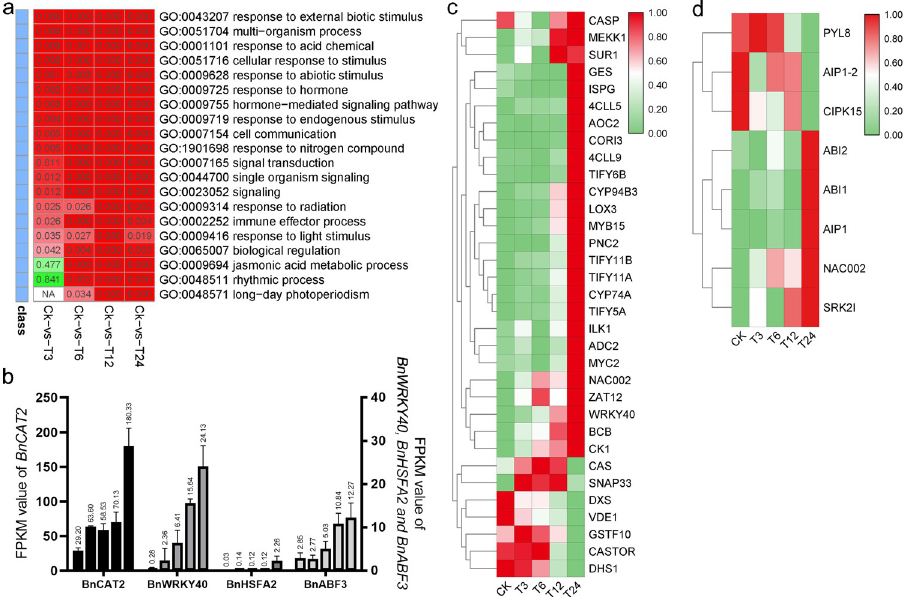
Fig 2. Gene Ontology (GO) clustering results and expression of key regulators. (a). Heatmap of GO Biological process terms in different comparisons. Red cell means p < 0.05, the redder the color, the lower the p -value. green cell means p > 0.05, the greener the color, the higher the p -value. The figures in the cells showed the p -value. (b) represents the expression level of four transcription factors. The number on the bar chart represents the average. (c) and (d) represent the expression of DEGs in jasmonic acid and abscisic acid signaling pathway, respectively. Red cell means p < 0.05, the redder the color, the lower the p -value. green cell means p > 0.05, the greener the color, the higher the p - value.